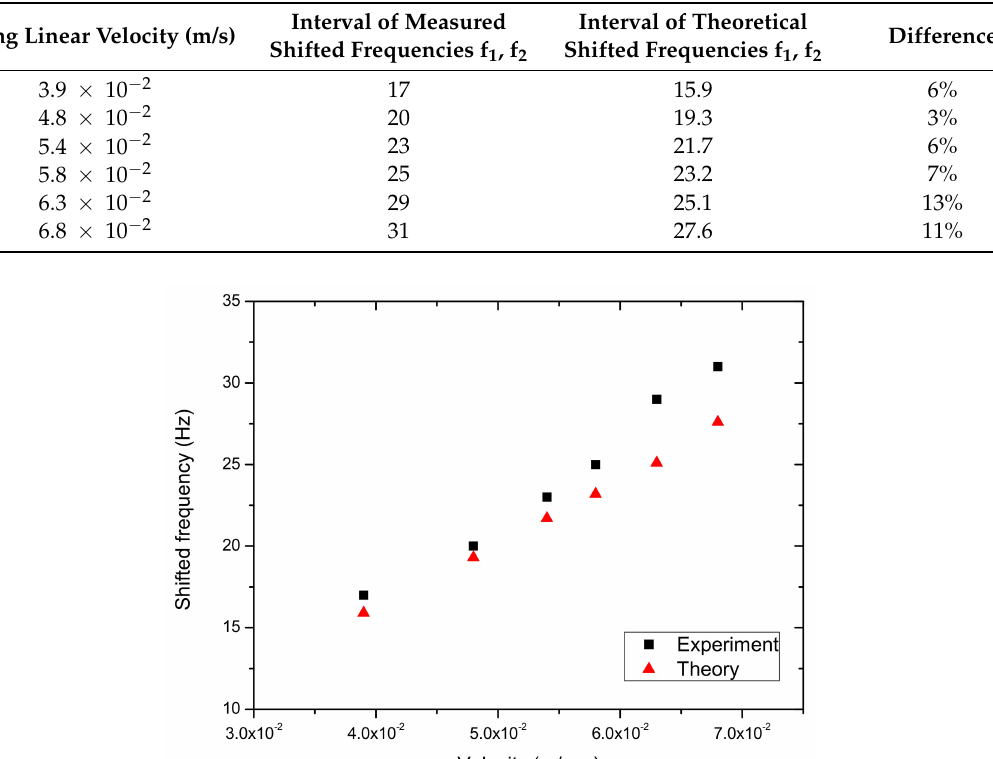
Table 3. Differences between measured and theoretical shifted frequencies at various velocities.